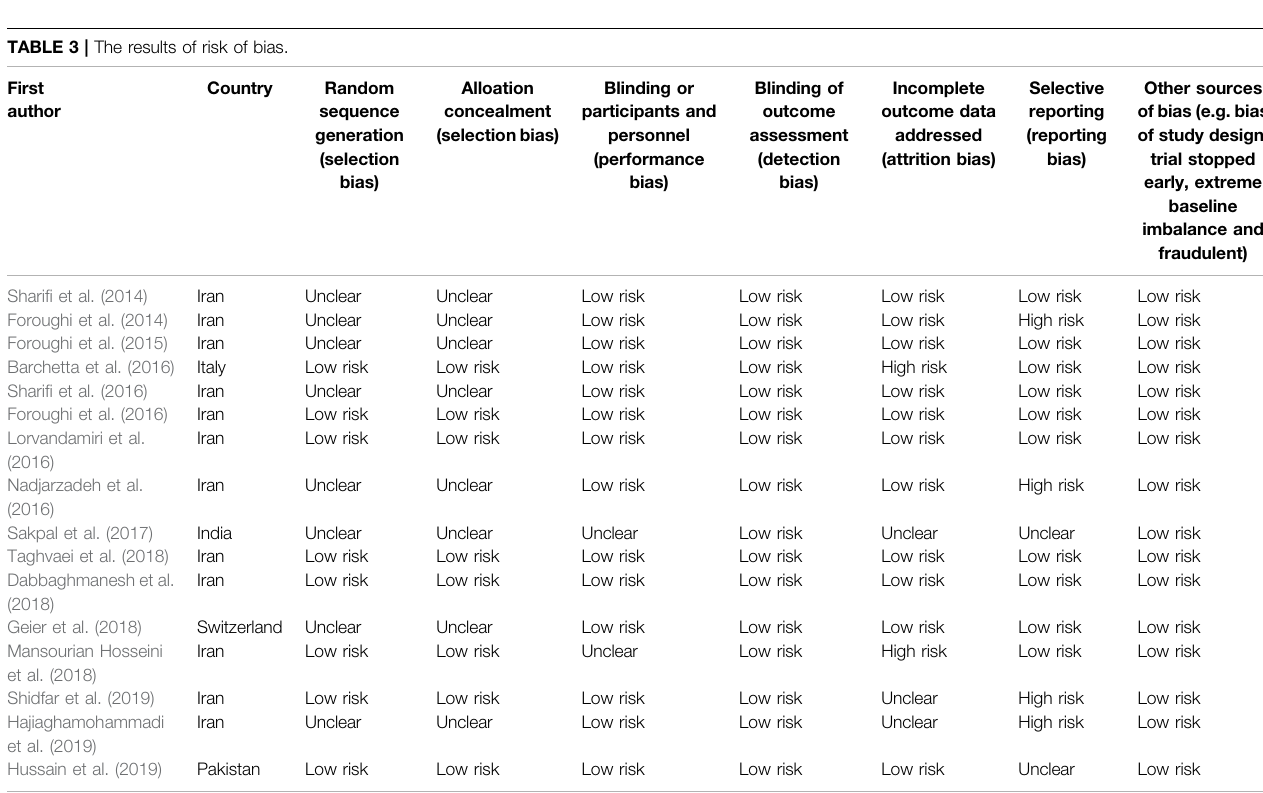
TABLE 3 | The results of risk of